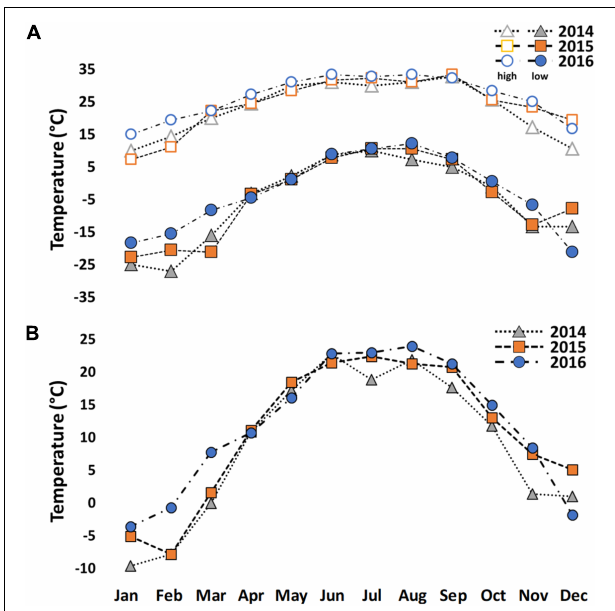
Analyses of field and electrolyte leakage data were made